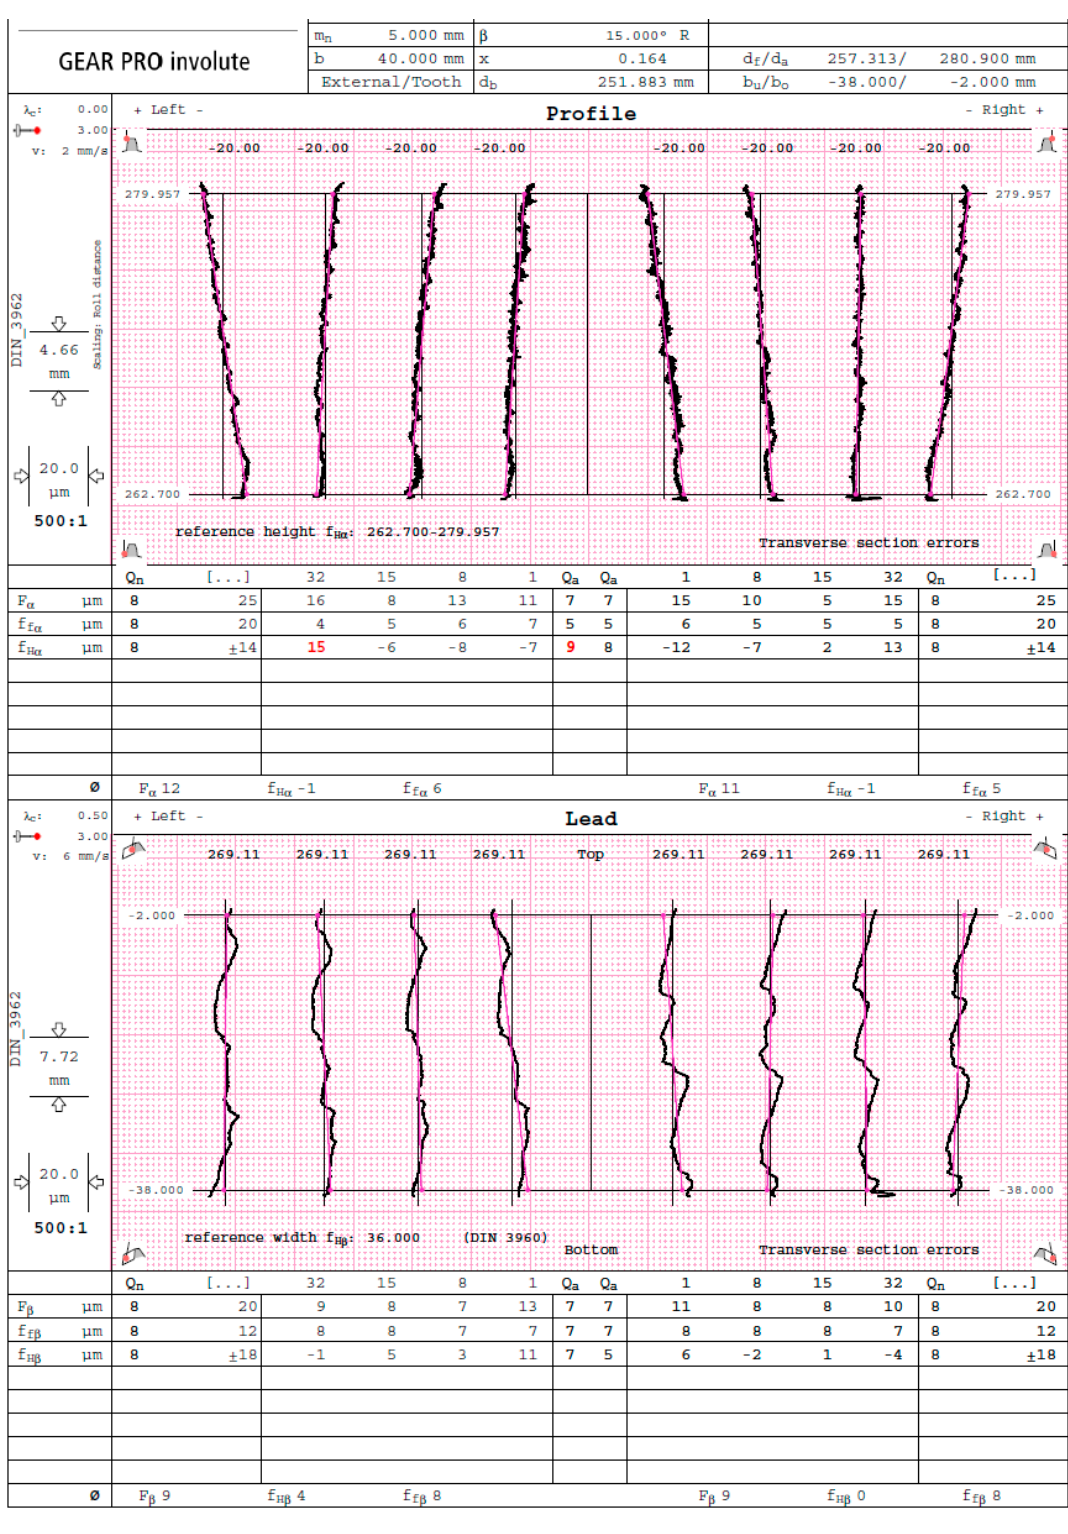
Figure 17. Measurement plot of one manufactured hard gear, with inserts of type 1010.